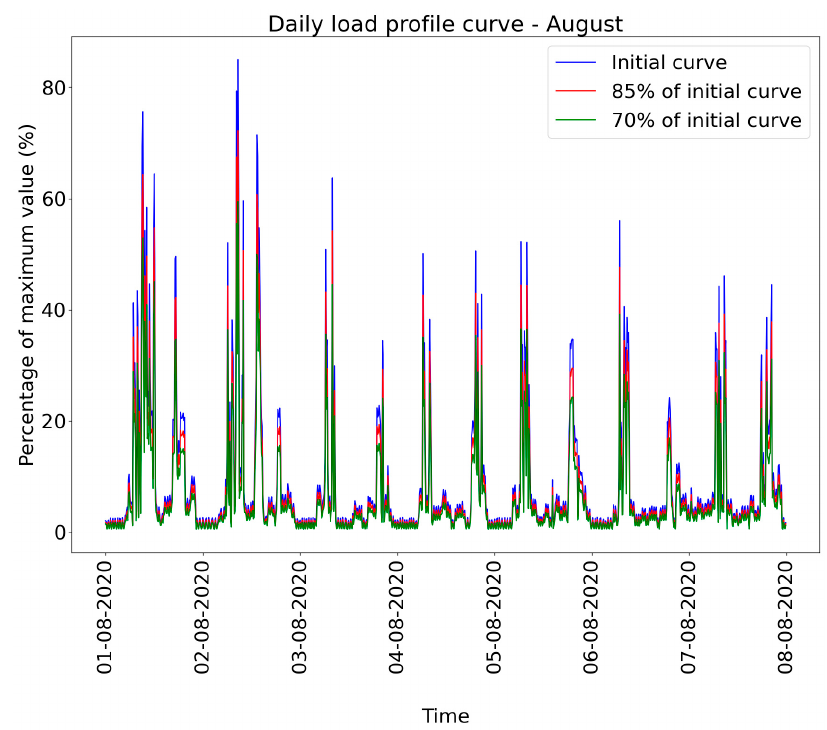
Figure A2. Load profile curve—August.